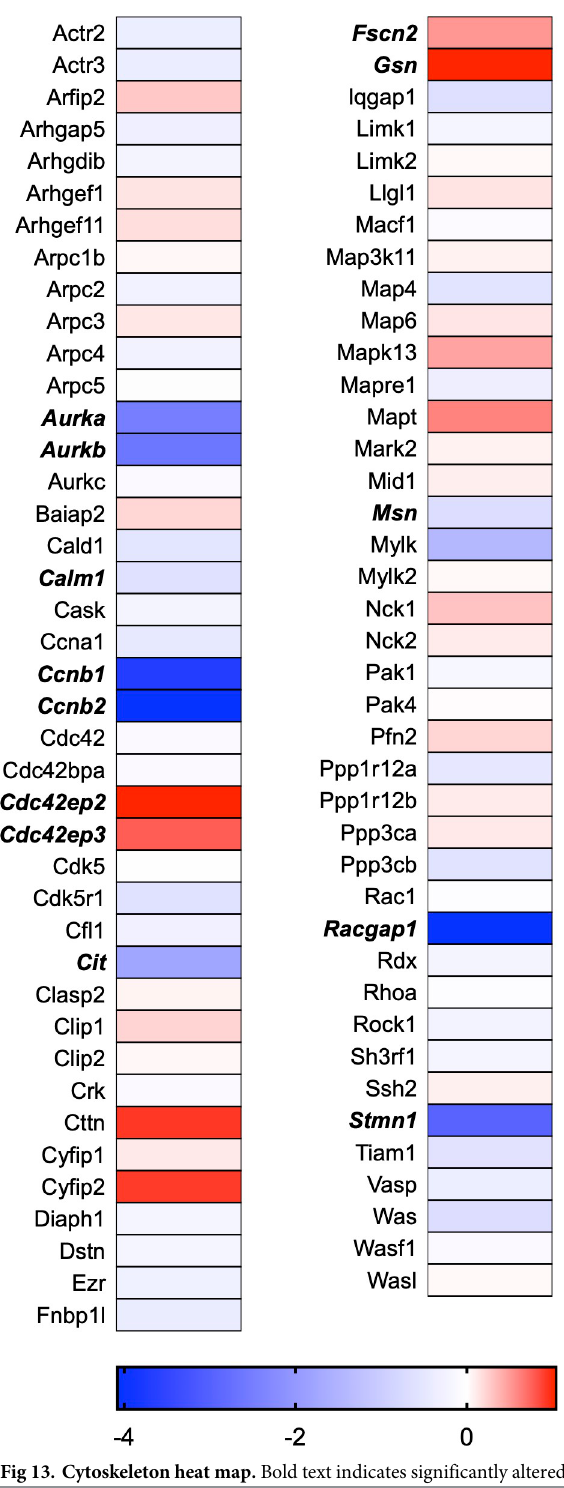
Fig 13. Cytoskeleton heat map. Bold text indicates significantly altered gene targets.